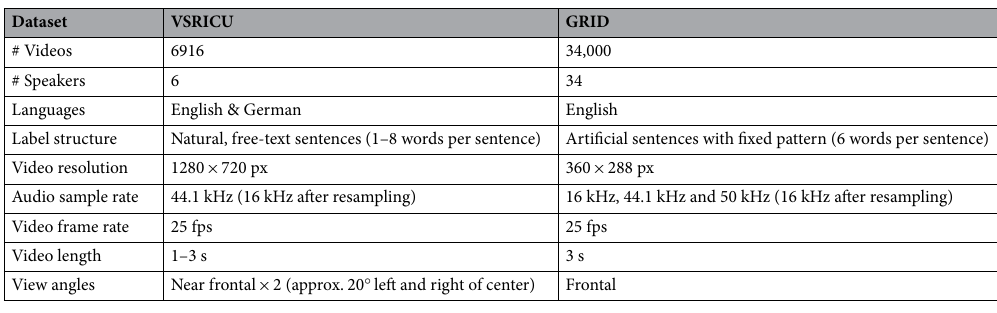
Table 1. Statistics for the VSRICU and GRID